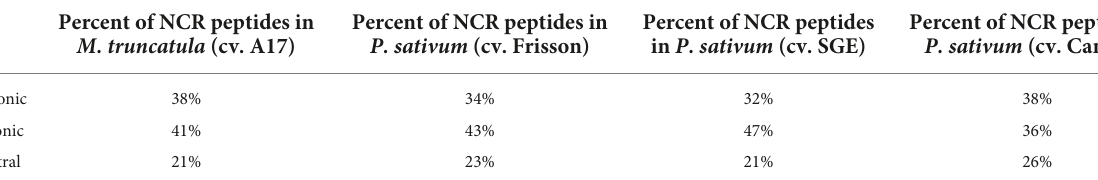
TABLE 3 Distribution of isoelectric points of NCR peptides in M. truncatula and P. sativum. Percent of NCR peptides in M. truncatula (cv. A17)